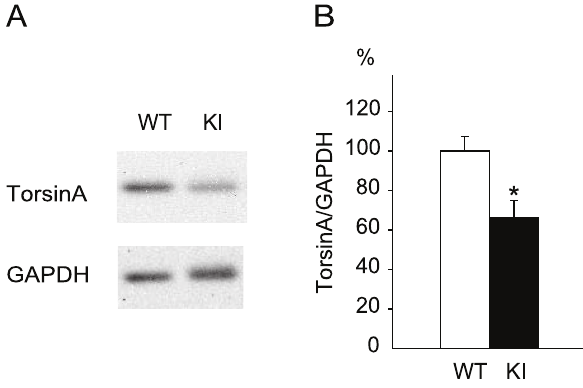
Figure 4. Reduced hippocampal torsinA in Dyt1 D GAG hetero- zygous KI mice. A representative band image of western blot (A) and the quantified hippocampal torsinA levels (B) from WT and Dyt1 D GAG heterozygous KI mice. The density of the torsinA band was standardized to that of GAPDH. The data in WT littermates were normalized to 100%. The vertical bars represent means 6 standard errors. * p ,